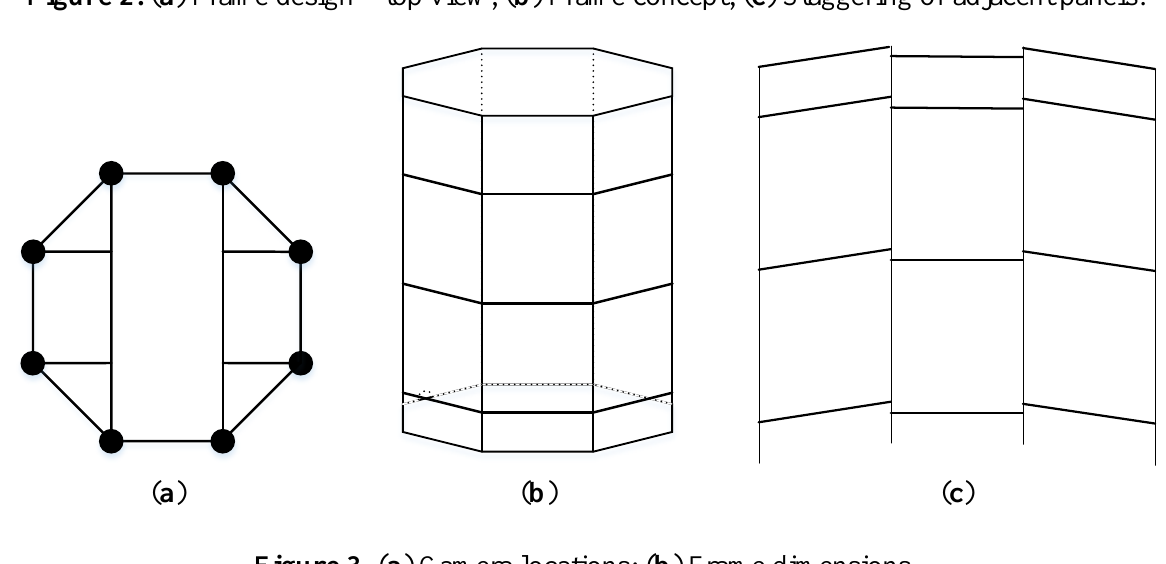
Figure 2. ( a ) Frame design—top view; ( b ) Frame concept; ( c ) Staggering of adjacent panels.